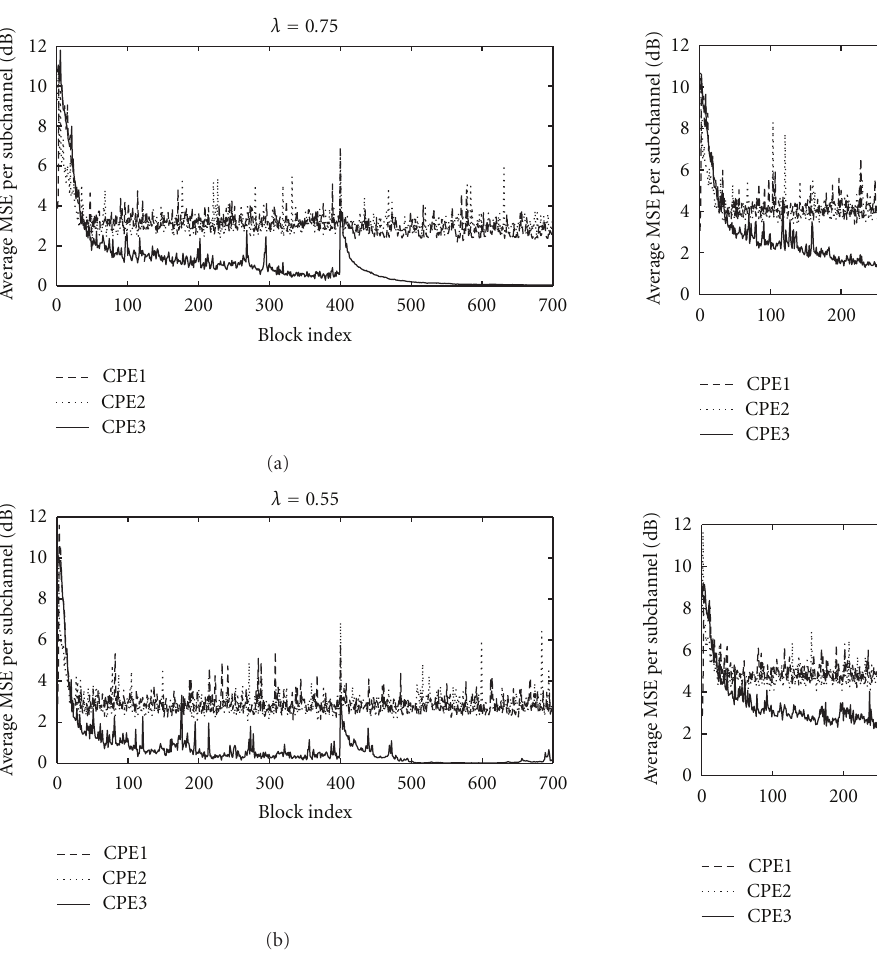
Figure 5: E ff ect of the forgetting factor λ on performance analysis curves of CPE1, CPE2, and CPE3 algorithms when tracking channels H 0( D ) and H 1( D ): λ = 0 . 75 (top plots) and λ = 0 . 55 (bottom plots).